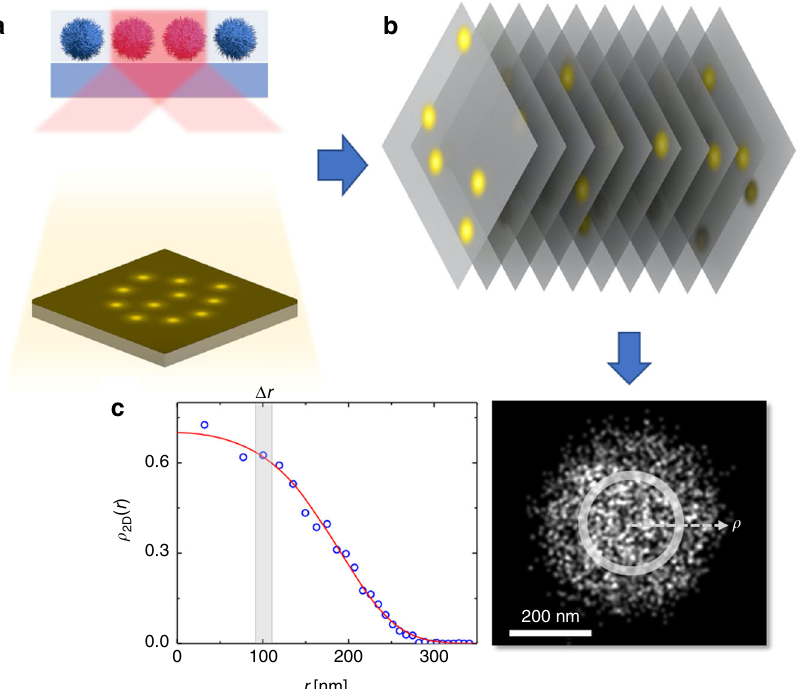
Fig. 3 Superresolution fl uorescent microscopy (SRFM). The most widely used method for soft-material imaging is single-molecule localization microscopy via direct STochastic Optical Reconstruction Microscopy (dSTORM) 48,57,58 . In dSTORM, a microgel can be labeled using conventional synthetic cyanine dyes such as Cy5 or dyes from the Alexa family. These dyes are then used as molecular photoswitches. a Highly inclined illumination of a microgel suspension with a laser beam (red shaded) to illuminate the dye-labeled particles within a few- μ m depth, next to a glass coverslip, in blue. The inclined or evanescent fi eld illumination reduces nonspeci fi c fl uorescence originating from the bulk of the sample. The illumination is provided by a powerful laser to achieve sparse fl uorophore blinking, as shown in the image below. In contrast, another laser wavelength is used to tune the density of blinking molecules 58 . b For every dSTORM image, thousands of frames are acquired whereby each frame consists of thousands of fl uorophore localizations, with typically thousands of photons detected per localization. The image acquisition takes up to several minutes, and therefore the microgels have to be immobilized on a glass substrate or trapped in a solid jammed or crystalline phase as in refs. 25,110 . c Experimental result for a swollen microgel particle attached to a glass substrate and reconstructed by dSTORM in 2D with a 30-nm lateral resolution. From individual or ensemble-averaged images of this type, the density pro fi le ρ 2 D ( r ) can be obtained by summing up the dye localizations in concentric rings around the center of mass. For spherical particles, ρ 2 D ( r ) can be converted into the three-dimensional (3D) density pro fi le ρ ( r ) as explained in refs. 58,86 . Alternatively, the ρ ð r directly in 3D as shown in Fig. 4. The dSTORM image and the single-microgel ρ 2 D ( r ) data have been adapted from ref. 58 (Fig. 2b; Supplementary Fig. S2), with permission from Elsevier, Copyright (2016). The solid red line shows the fi t with Eq. (1) and R c = 227 nm and σ = 40.5